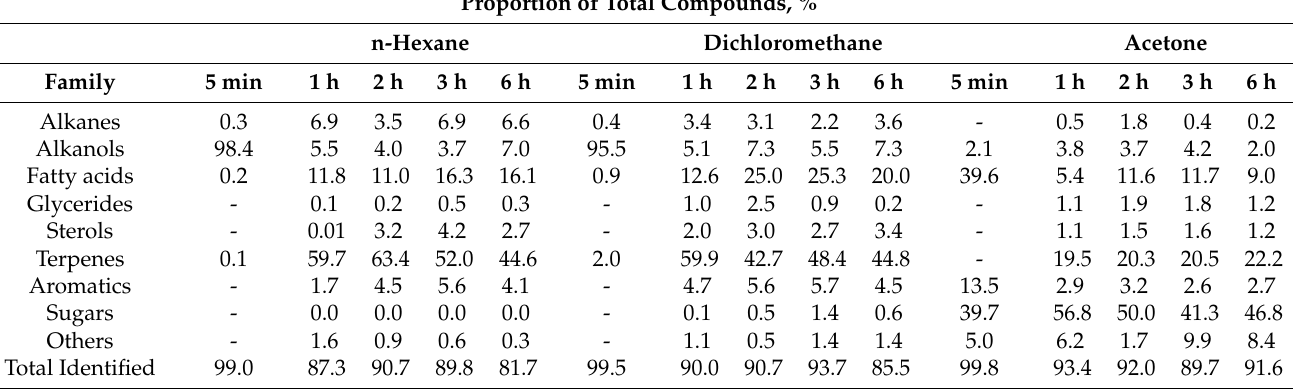
Table 2. Composition of the cuticular extracts of leaves from Q. suber solubilised by different solvents and extraction times by chemical class as a percentage of total peak area in the GC–MS chromatograms.